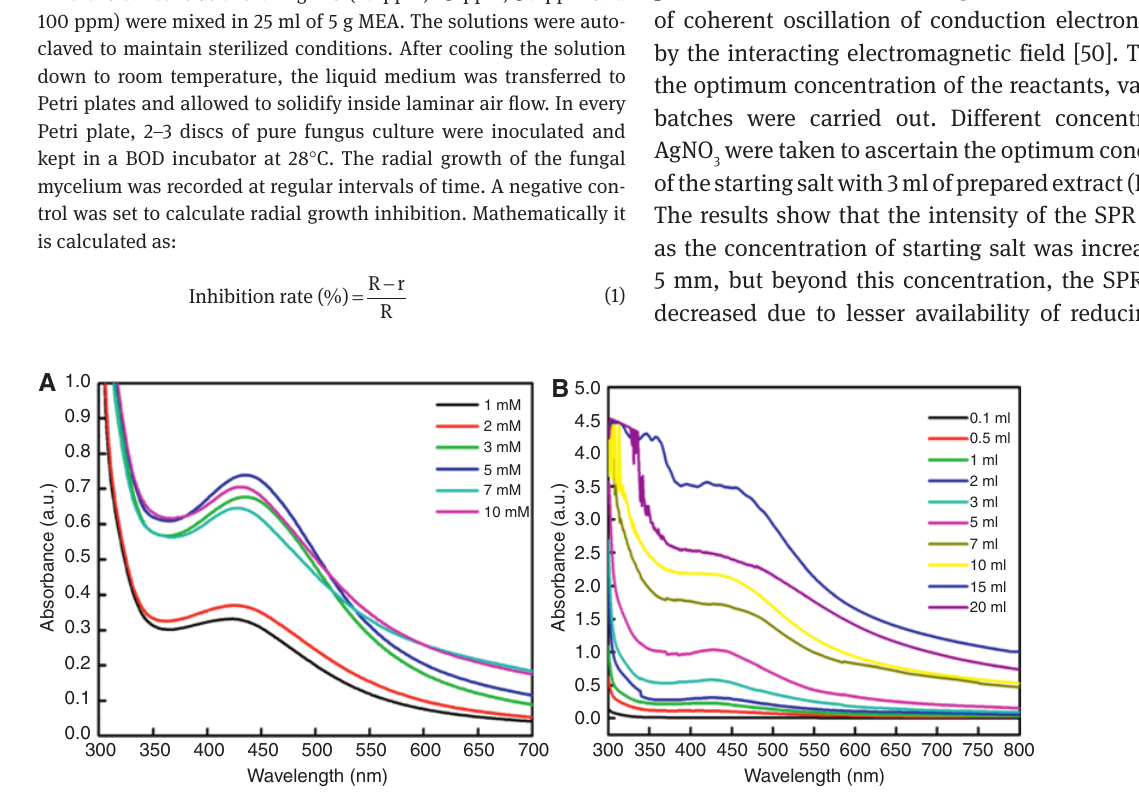
concentration and (B) plant extract 3